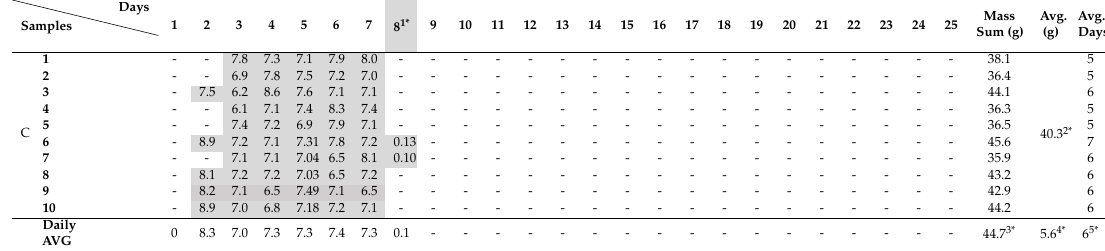
Table 7. Oil leakage mass measurement results (specimen C).